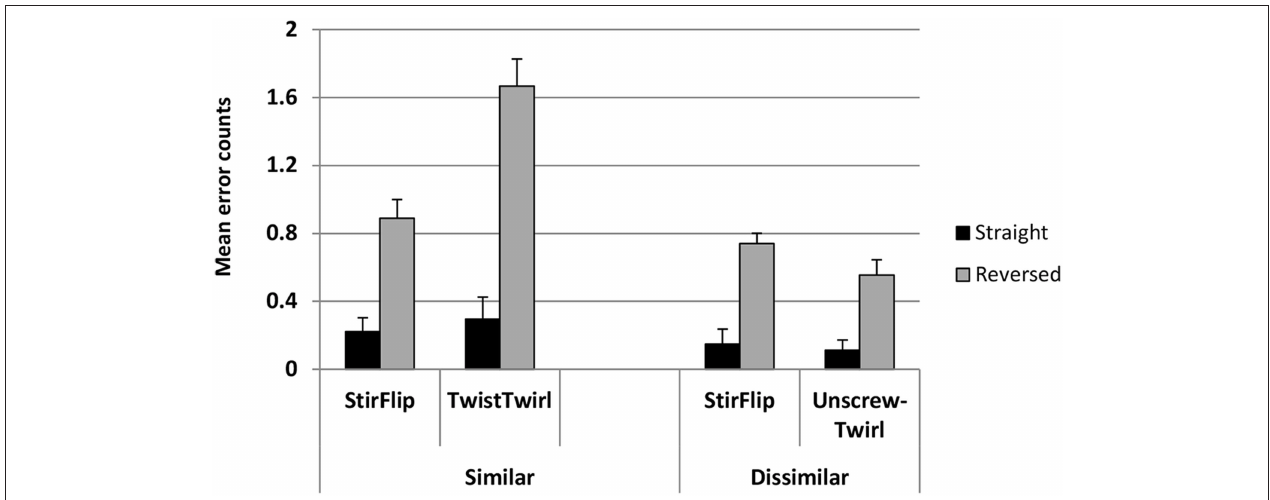
FIGURE 4 | Mean error counts ( + SE) for similar and dissimilar conditions for each pair of words in each phase.